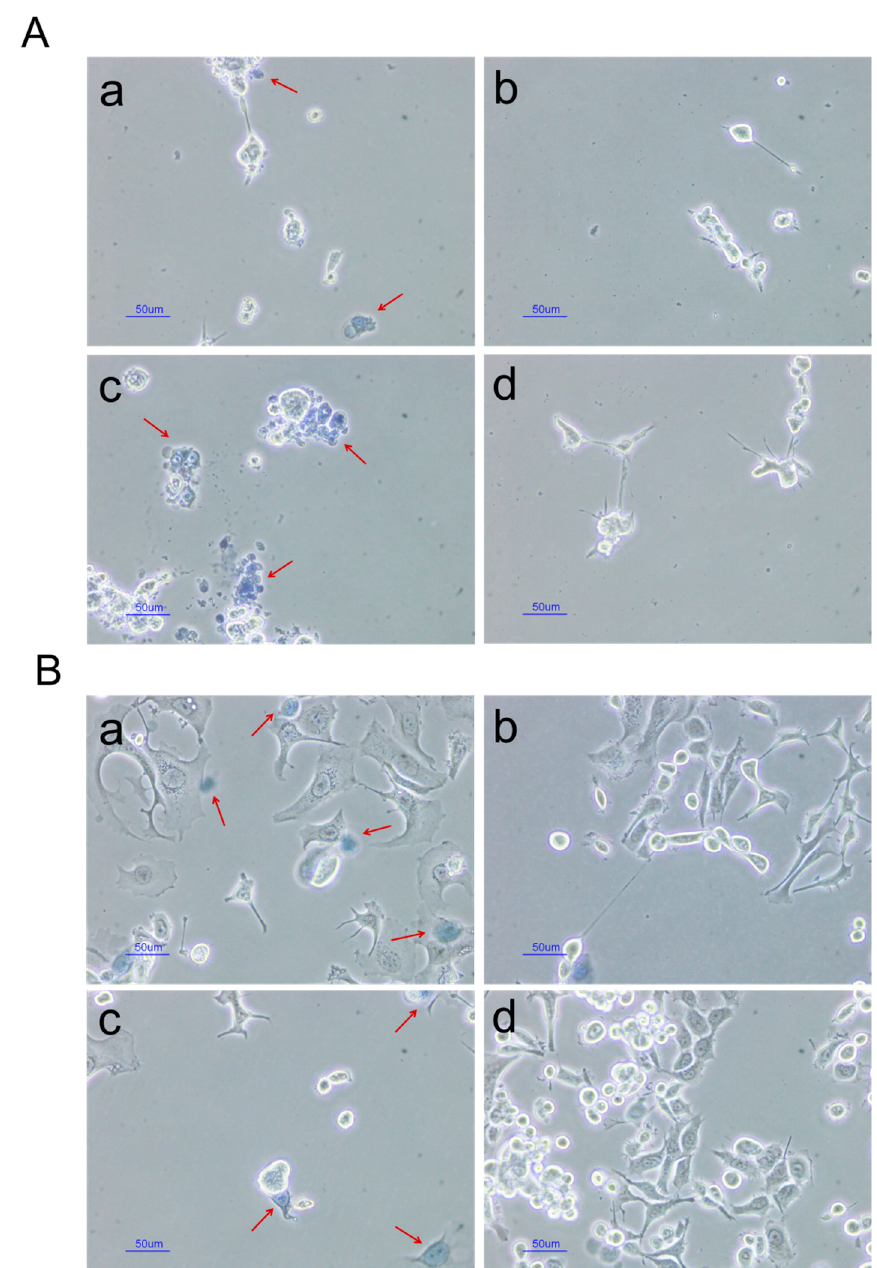
Figure 6. Results of trypan blue assay after treating CWR22Rv1 cells ( A ) and MCF-7 cells ( B ) with MTX ( a , 0.01 mg / mL), blank NPs ( b ), MTX-loaded PLGA NPs ( c , 0.01 mg / mL as MTX), or control ( d ). free MTX ( a , 0.01 mg/mL), blank NPs ( b ), MTX-loaded PLGA NPs ( c , 0.01 mg/mL as MTX), or (cid:45) : trypan blue stained control ( d ). ↖ : trypan blue stained cells.